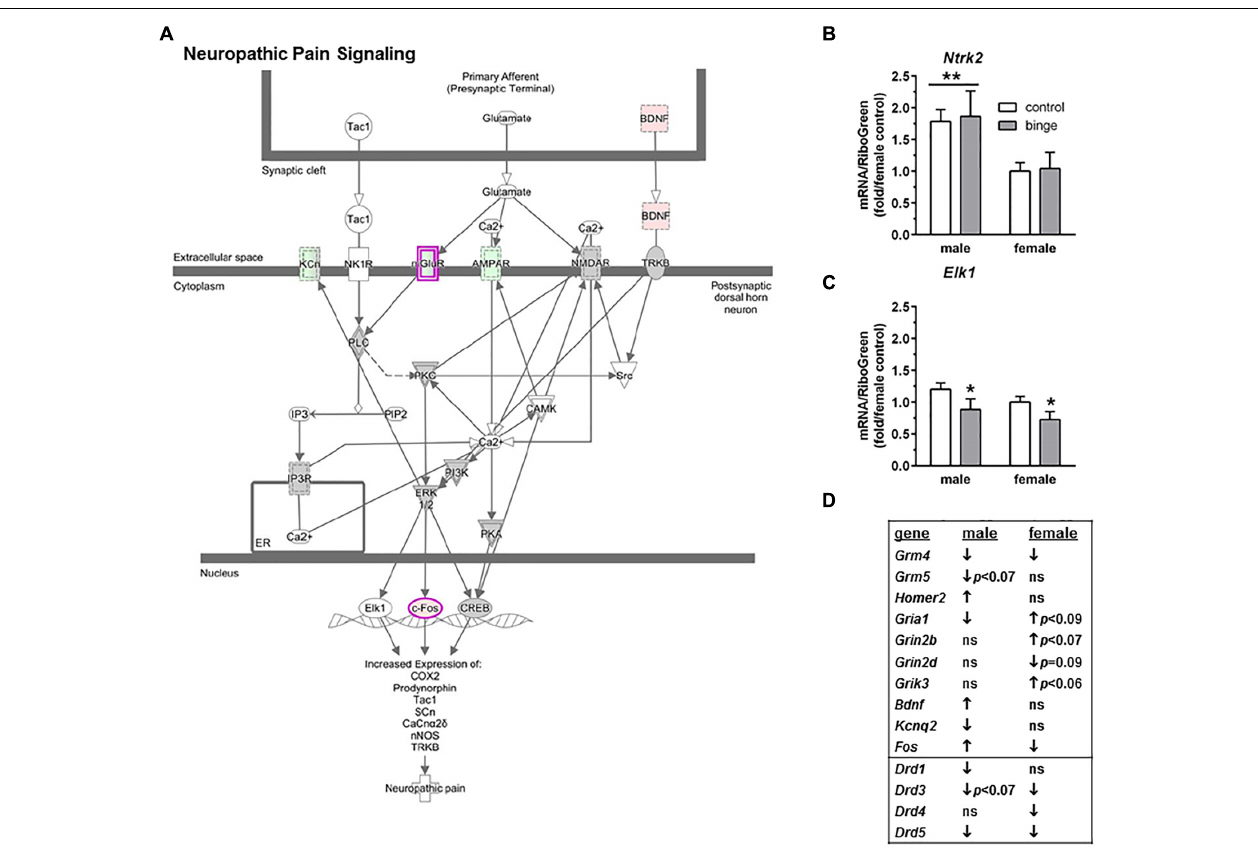
FIGURE 4 | Simplified neuropathic pain signaling pathway highlights genes influenced by repeated binge drinking in male and female mice. This canonical pathway was identified by IPA as regulated by binge drinking in both males and females. (A) Depicts the neuropathic pain signaling pathway and highlights genes regulated by binge drinking in males (pink for up-regulation, green for down-regulation). (B,C) Depict qRT-PCR results and show that expression of Ntrk2 ( B which encodes TrkB) was significantly higher in males than in females. Expression of Elk1 ( C which encodes transcription factor Elk1) was significantly decreased by binge drinking in both sexes. Values are the mean ± SEM for 4/sex/treatment. ∗ p < 0.05 for main effect of treatment, ∗∗ p = 0.01 for main effect of sex (over horizontal line). (D) Shows significant regulation by binge drinking of select genes from the qPCR array analysis in male and female mice that are pertinent to the neuropathic signaling cascade depicted in (A) (top 10 genes) or that are pertinent to effects on other receptor systems ( ↑ for up-regulation, ↓ for down regulation; p ≤ 0.05 at a minimum). For statistical trends, the p -values are provided. Ntrk2 (neurotrophic tyrosine kinase, receptor, type 2) encodes the protein TrkB (tropomyosin receptor kinase B). Elk1 (ELK1, member of ETS oncogene family) encodes the transcription factor